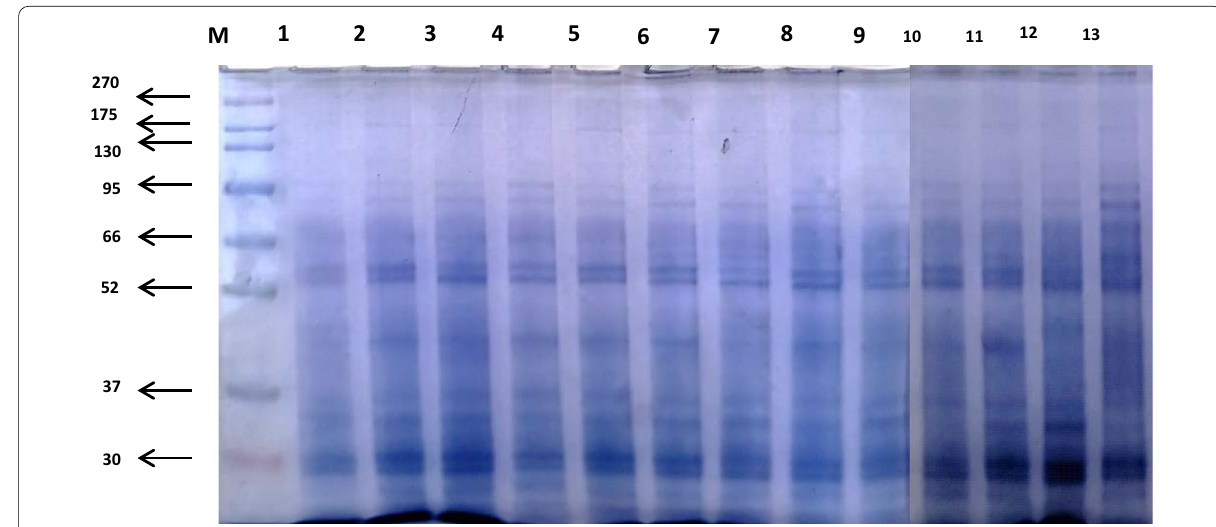
Fig. 2 Protein banding patterns in 13 rice genotypes (eight parents and the highest five hybrids) under drought stress conditions. Lane 1 lane 2: 9 eight parents genotypes and lane 10: 14 =